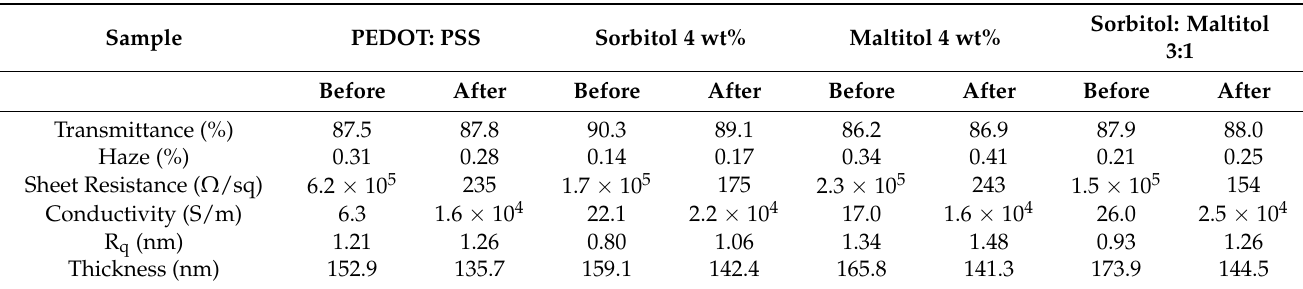
Table 4. Transmittance, haze, sheet resistance, conductivity, and R q of PEDOT: PSS without and with different organic additives and subjected to FA treatment (before and after).